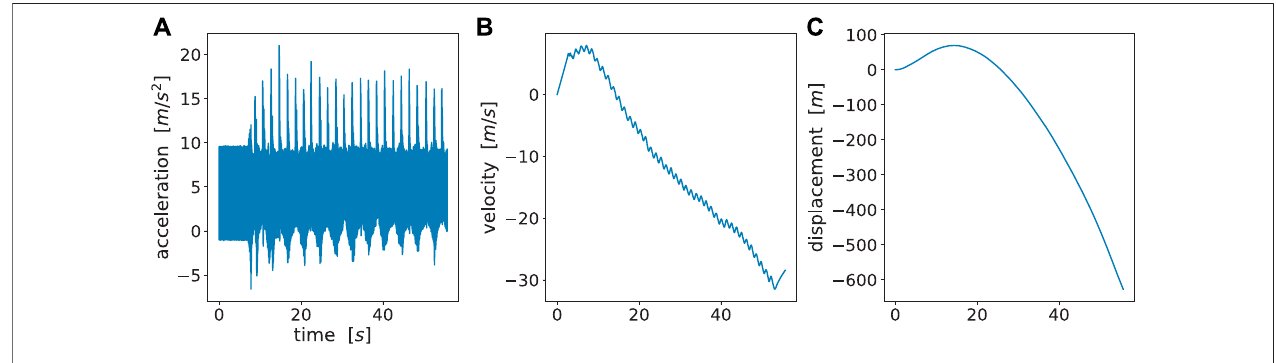
FIGURE 6 | (A) Raw acceleration data, (B) reconstructed velocity pro fi le, (C) reconstructed acceleration pro fi le. There is a large drift for velocity and displacement as no periodic patterns can be observed. A reasonable reconstruction should at least show periodic patterns as acceleration pro fi le.